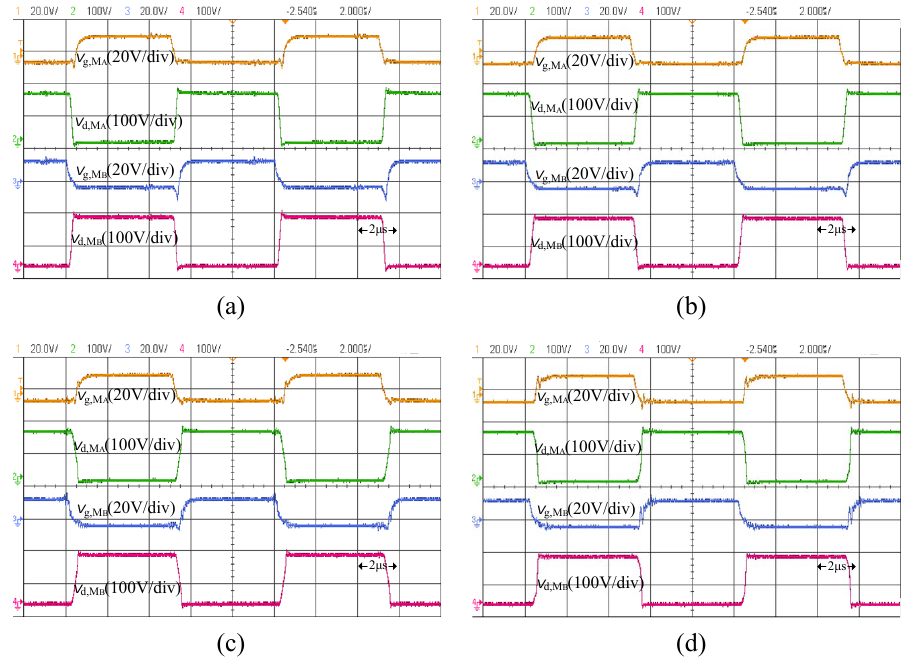
, v d , M , v g , M , and v d , M of M A and M B at different power B A B A